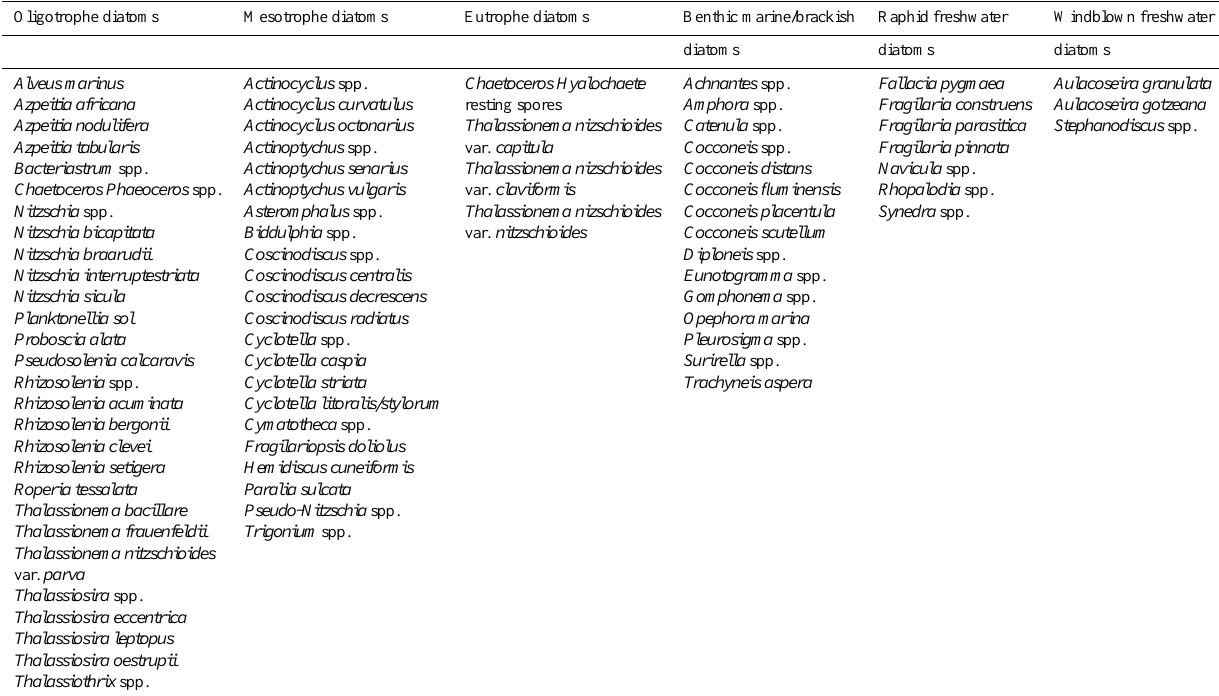
Table 1. List of diatom species or species groups included in the different groups. Diatom group identification and diatom species assignment are detailed in the